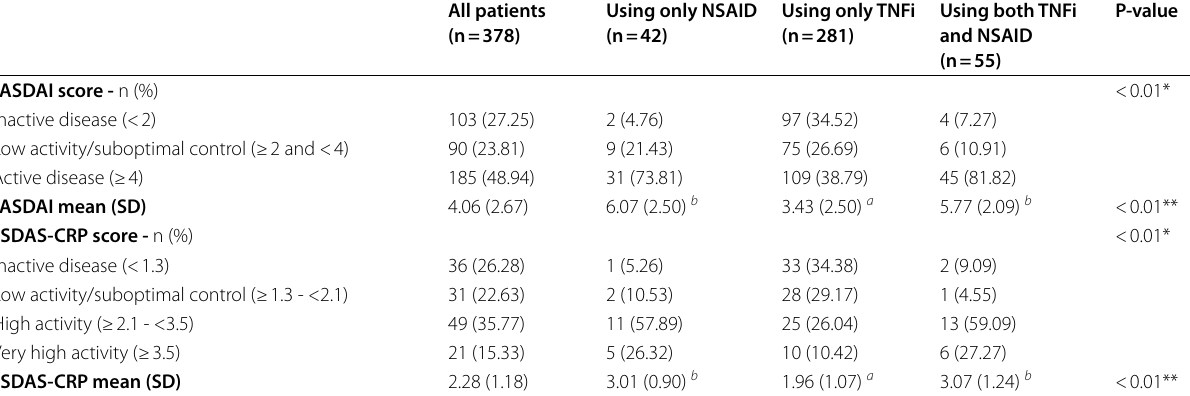
Table 2 Disease activity according to treatment